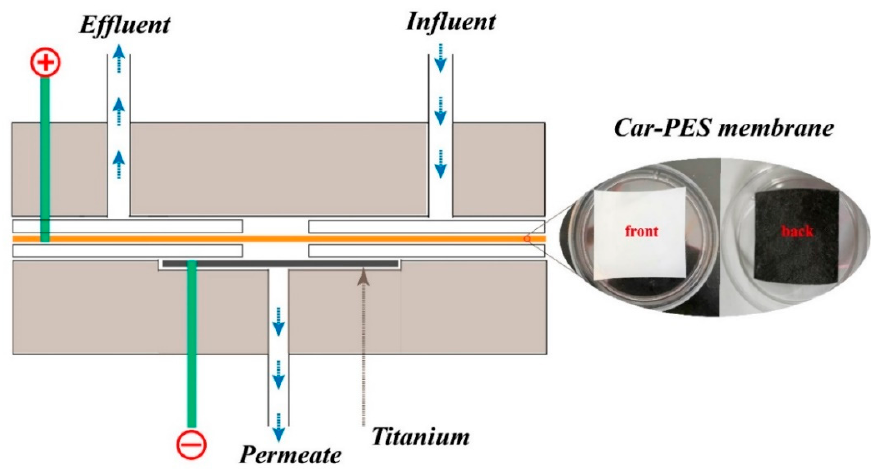
Figure 1. Electrochemical cross flow filtration model of Car-PES composite conductive separation membrane.